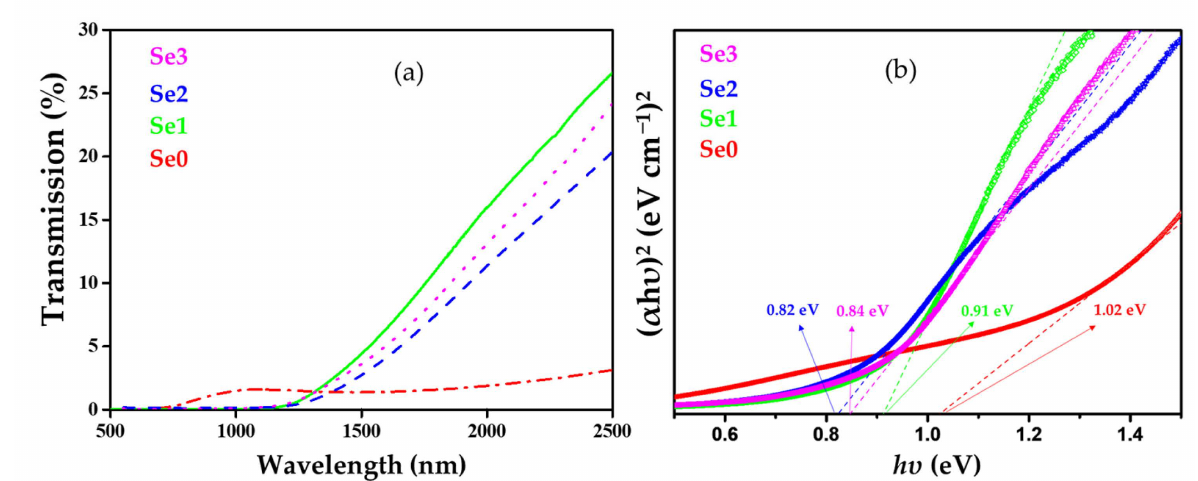
Figure 10. ( a ) Transmission spectra and ( b ) bandgap of CZTSe thin films.